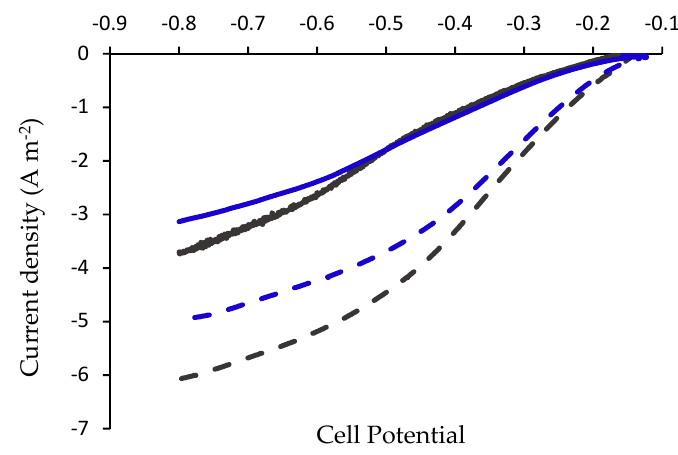
Energies 2019 , 12 , x FOR PEER REVIEW 5 of 15 Figure 1. Linear Sweep Voltammetry ( LSV) polarization curves for a bacterial anode made of Figure 3. LSV polarization curves for a cathode in a MEC based on anodes made of CC ( ), COMB Figure 1. Linear Sweep Voltammetry ( LSV) polarization curves for a bacterial anode made of Figure 1. Linear Sweep Voltammetry ( LSV) polarization curves for a bacterial anode made of Figure 1. Linear Sweep Voltammetry ( LSV) polarization curves for a bacterial anode made of CC ( ), COMB ( ), SS ( ); CCP ( ) and COMBP ( ) in a single-cell microbial electrolysis ) and COMBP ( ) in a single-cell microbial electrolysis ) in a single-cell microbial electrolysis ); CCP ( ) and COMBP ( ) in a single-cell microbial electrolysis cell (MEC) containing Geobacter medium and 0.1 M PB, pH7. Scan rate was 5 mV s − 1 versus Ag/AgCl. Figure 3. LSV polarization curves for a cathode in a MEC based on anodes made of cell (MEC) containing Geobacter medium and 0.1 M PB, pH7. Scan rate was 5 mV s − 1 versus Ag/AgCl. cell (MEC) containing Geobacter medium and 0.1 M PB, pH7. Scan rate was 5 mV s − 1 versus cell (MEC) containing Geobacter medium and 0.1 M PB, pH7. Scan rate was 5 mV s − 1 versus Ag/AgCl. CC ( ), COMB ( ), CCP ( ) and COMBP ( ) in a single-cell MEC containing